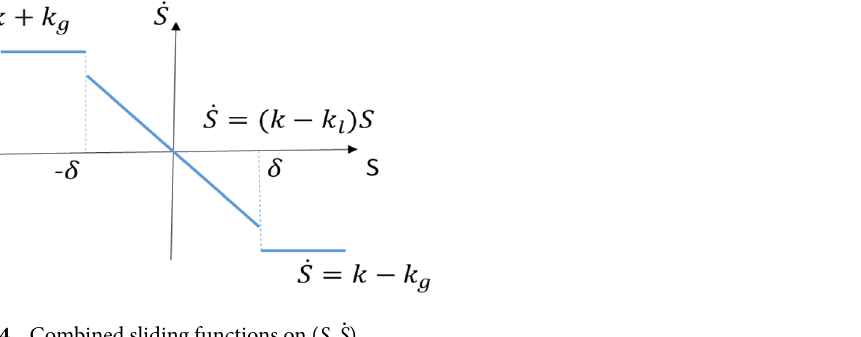
Figure 4. Combined sliding functions on ( S ,